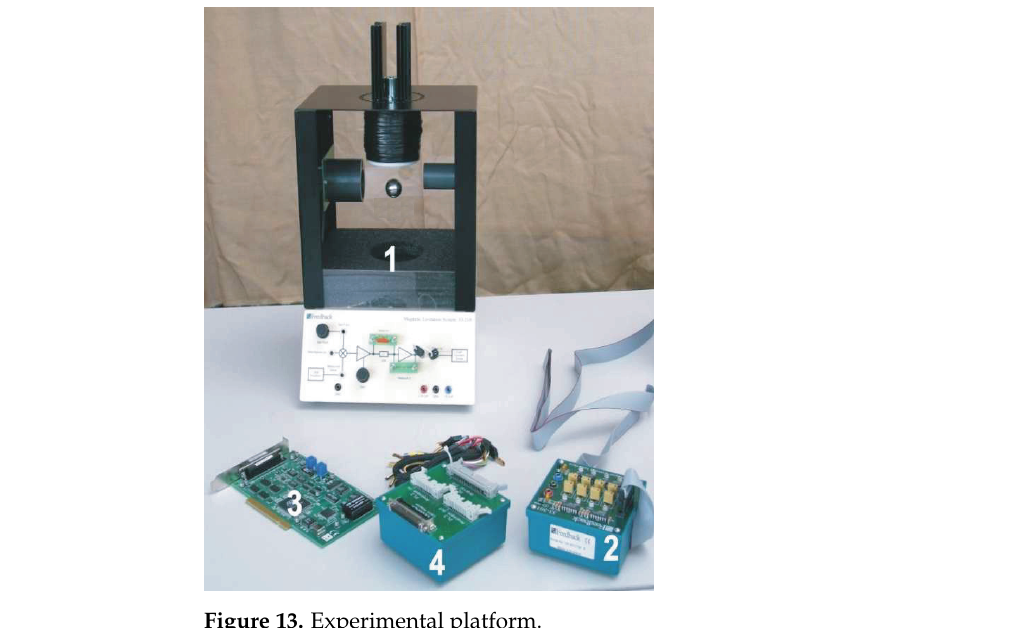
Figure 13. Experimental platform.